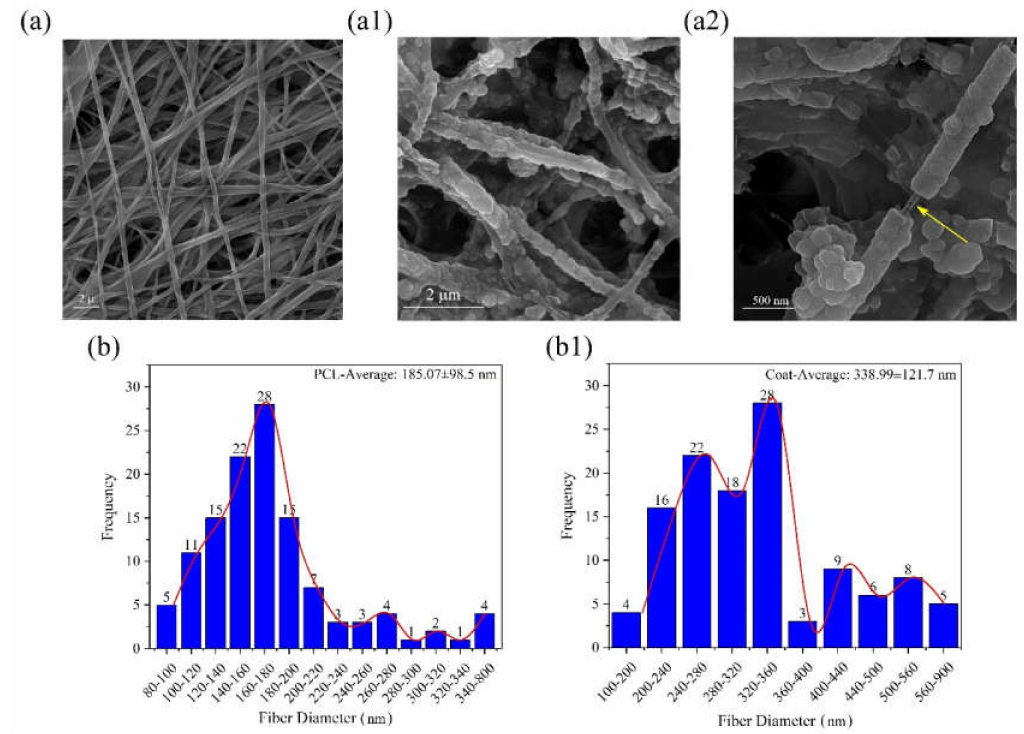
Figure 4. ( a ) SEM morphology of pristine PCL (control); ( a1 , a2 ) SEM morphology of aminolized PCL electrospun mats grafted with collagen / chitosan blend under di ff erent magnifications (arrow shows a typical uncoated part); ( b , b1 ) comparative histograms of fiber diameter before (b) and after (b1)